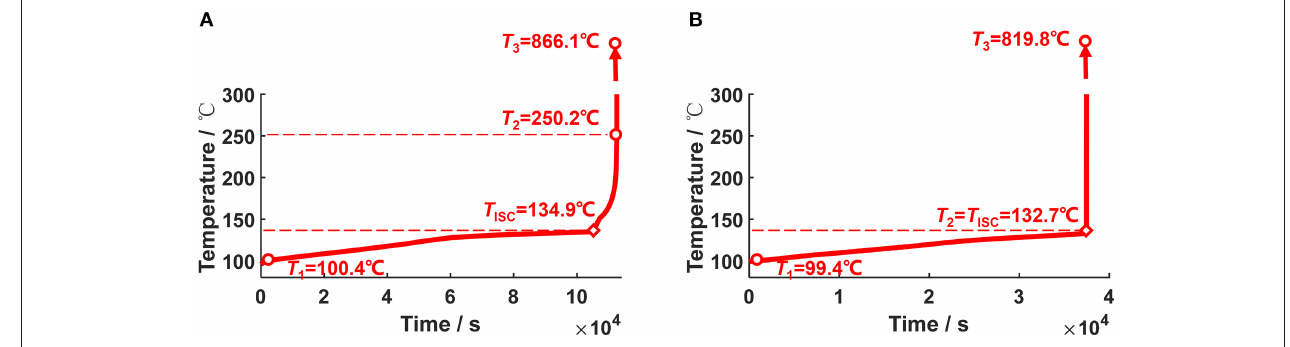
FIGURE 12 | Two different ARC test results for Battery Sample B. (A) A case when TR occurs at 250.2 ◦ C, (B) A case when TR occurs at 132.7 ◦